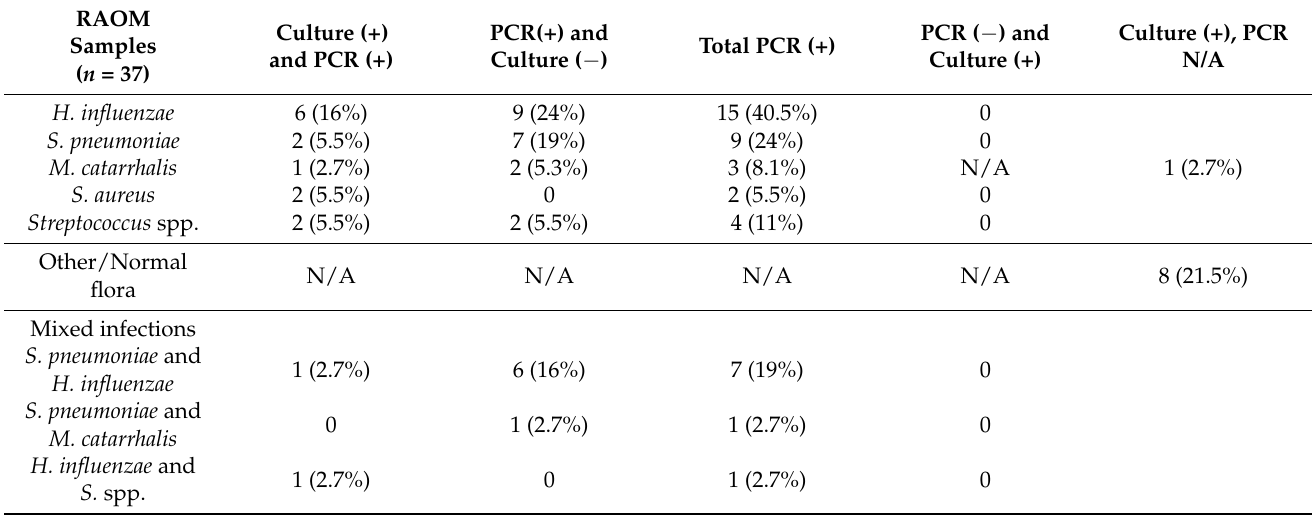
Table 2. Pathogen identification in RAOM samples by culture and